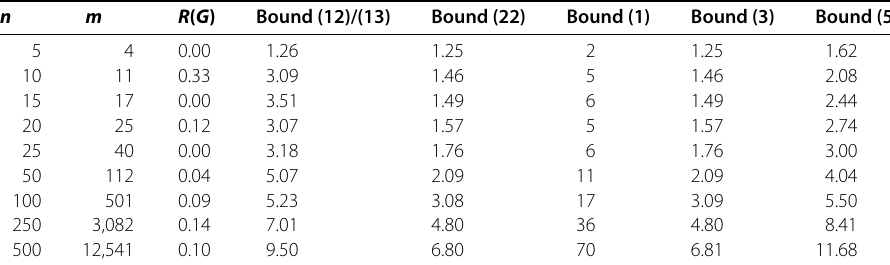
Table 3 Upper bounds of R ( G ) for graphs generated by G ER ( n ,0.1) model